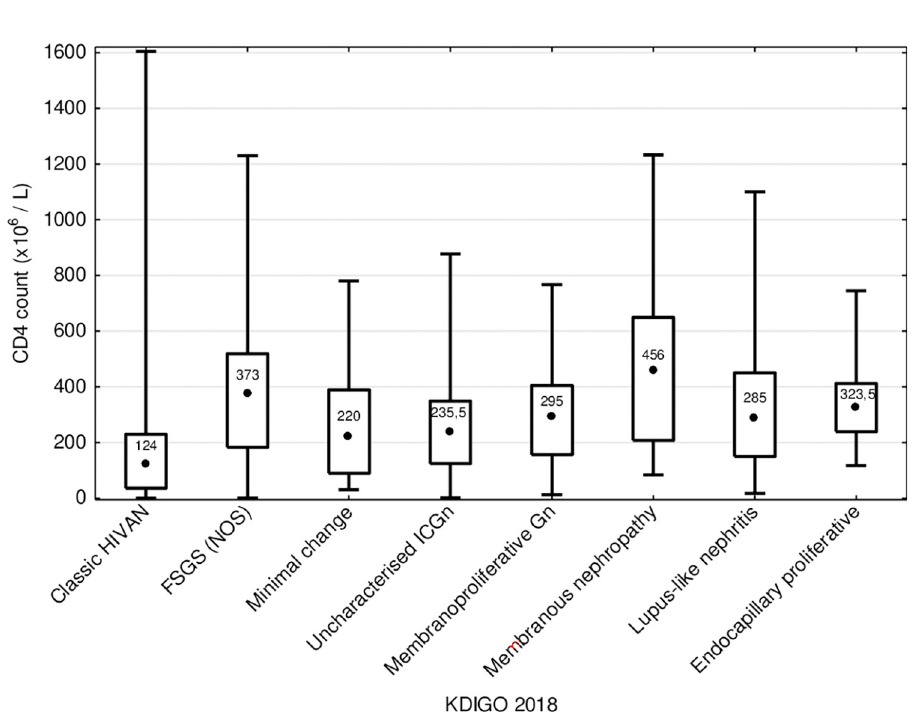
Fig 2. CD4 count at presentation among glomerular-dominant lesions in HIV-positive patients who underwent a native kidney biopsy.